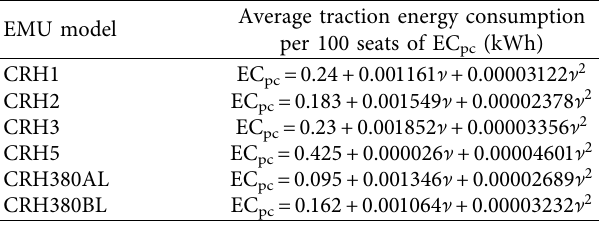
Table 4: Resistance-based equations for calculating the average traction energy consumption per 100 seats of EMUs on a flat and straight line.